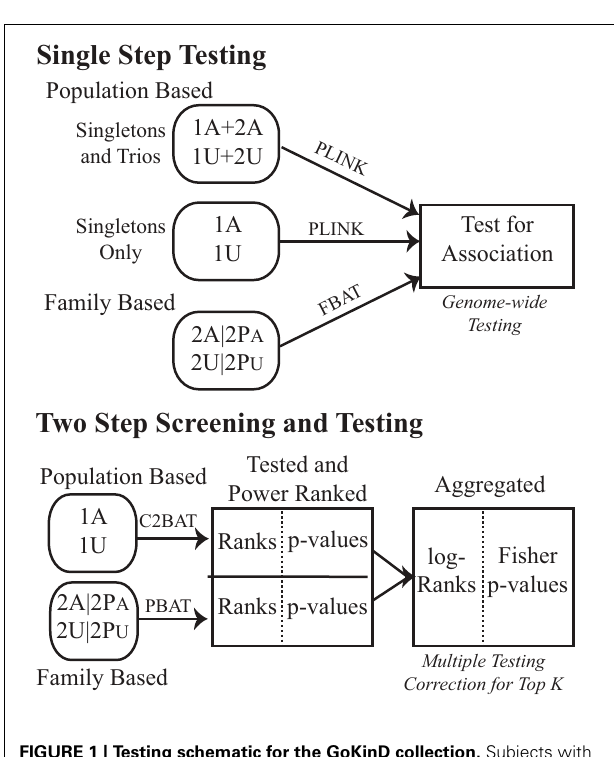
FIGURE 1 | Testing schematic for the GoKinD collection. Subjects with type 1 diabetes with (affected) and without (unaffected) diabetic nephropathy were studied for genetic association. Population- and family-based subsets were either tested in a typical straight-forward single-step strategy or in a two-step combination strategy with conditional screening for power, association testing and subsequent combination of the two. To distinguish between the data subsets used, 1 (cid:2) s indicate unrelateds and 2 (cid:2) s are from the family samples. A denotes affected and U unaffected. The analytic methods used are indicated above the corresponding